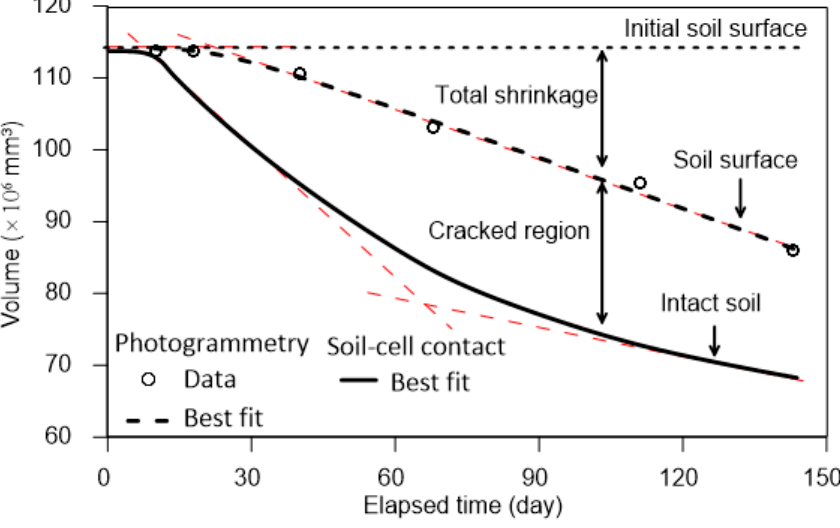
Figure 8. Comparison of photogrammetric volume and soil–cell contact volume.